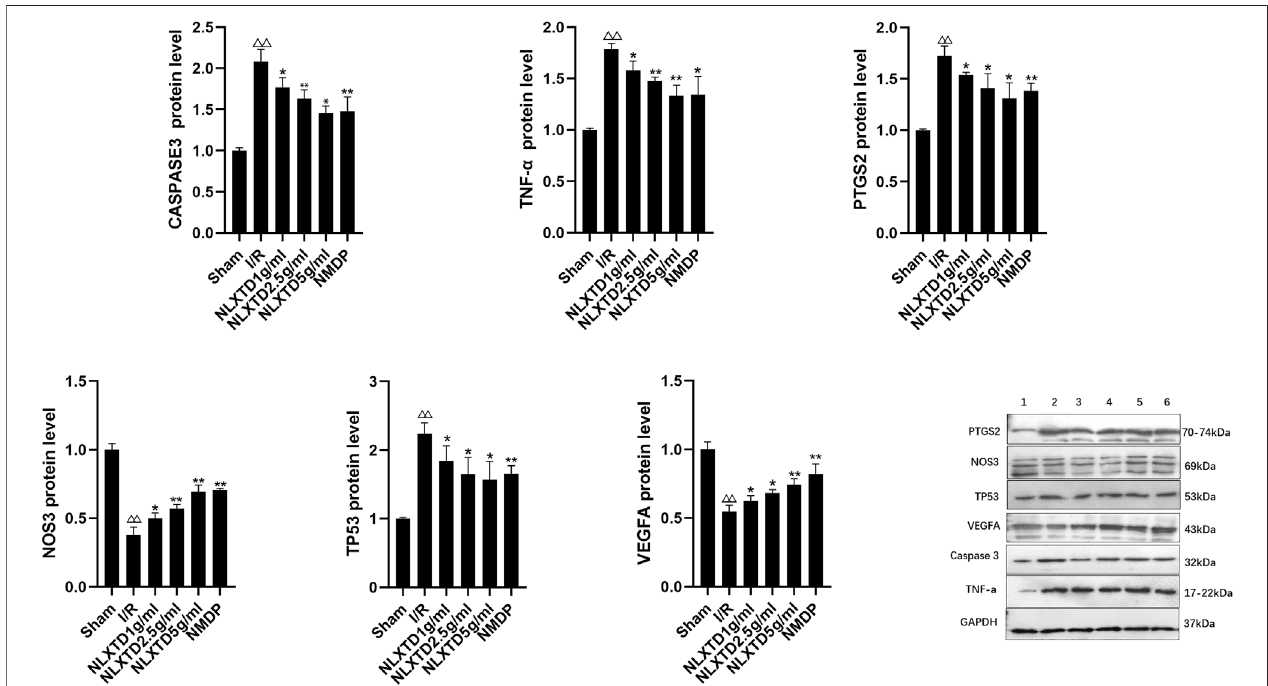
FIGURE8| Proteinexpression ofCASP3, TNF, PTGS2,TP3,NOS3 andVEGFA.Notes: △△ p < 0.01vs.Sham group;** p < 0.01,* p < 0.05vs. I/Rgroup. 1:Sham, 2: I/R, 3: NLXTD5 g/ml, 4:NLXTD2.5 g/ml, 5: NLXTD1 g/ml, 6: NMDP ( n =